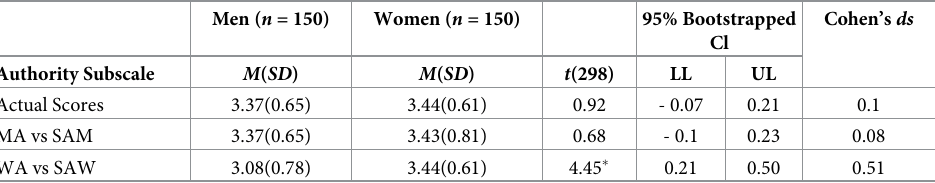
Table 5. Comparison of gender on actual and stereotype scores on authority subscale (N = 300).